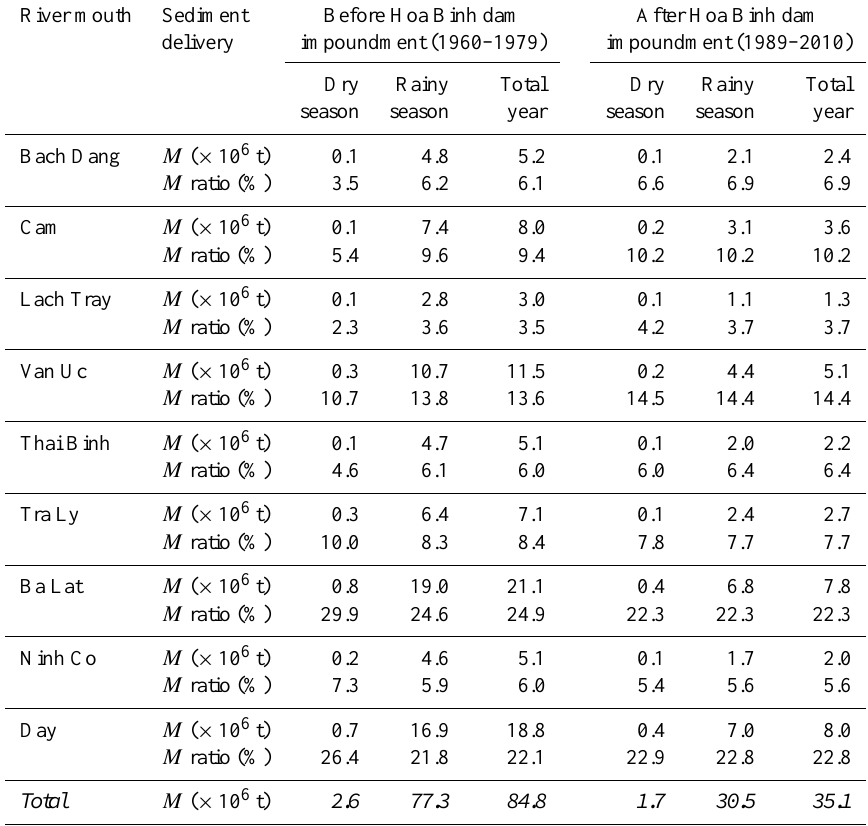
Table 4. Average suspended sediment fluxes in the nine distributaries of the Red River obtained from numerical simulations in the dry season (December–April), the rainy season (June–October), and per year, before (1960–1979) and after (1989–2010) Hoa Binh dam